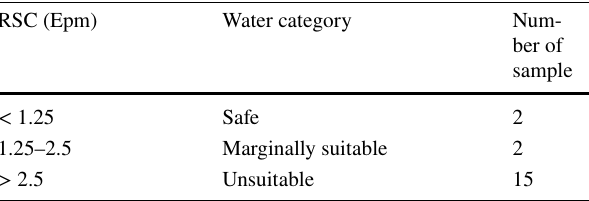
Table 6 Classification of samples on RSC value (Richards